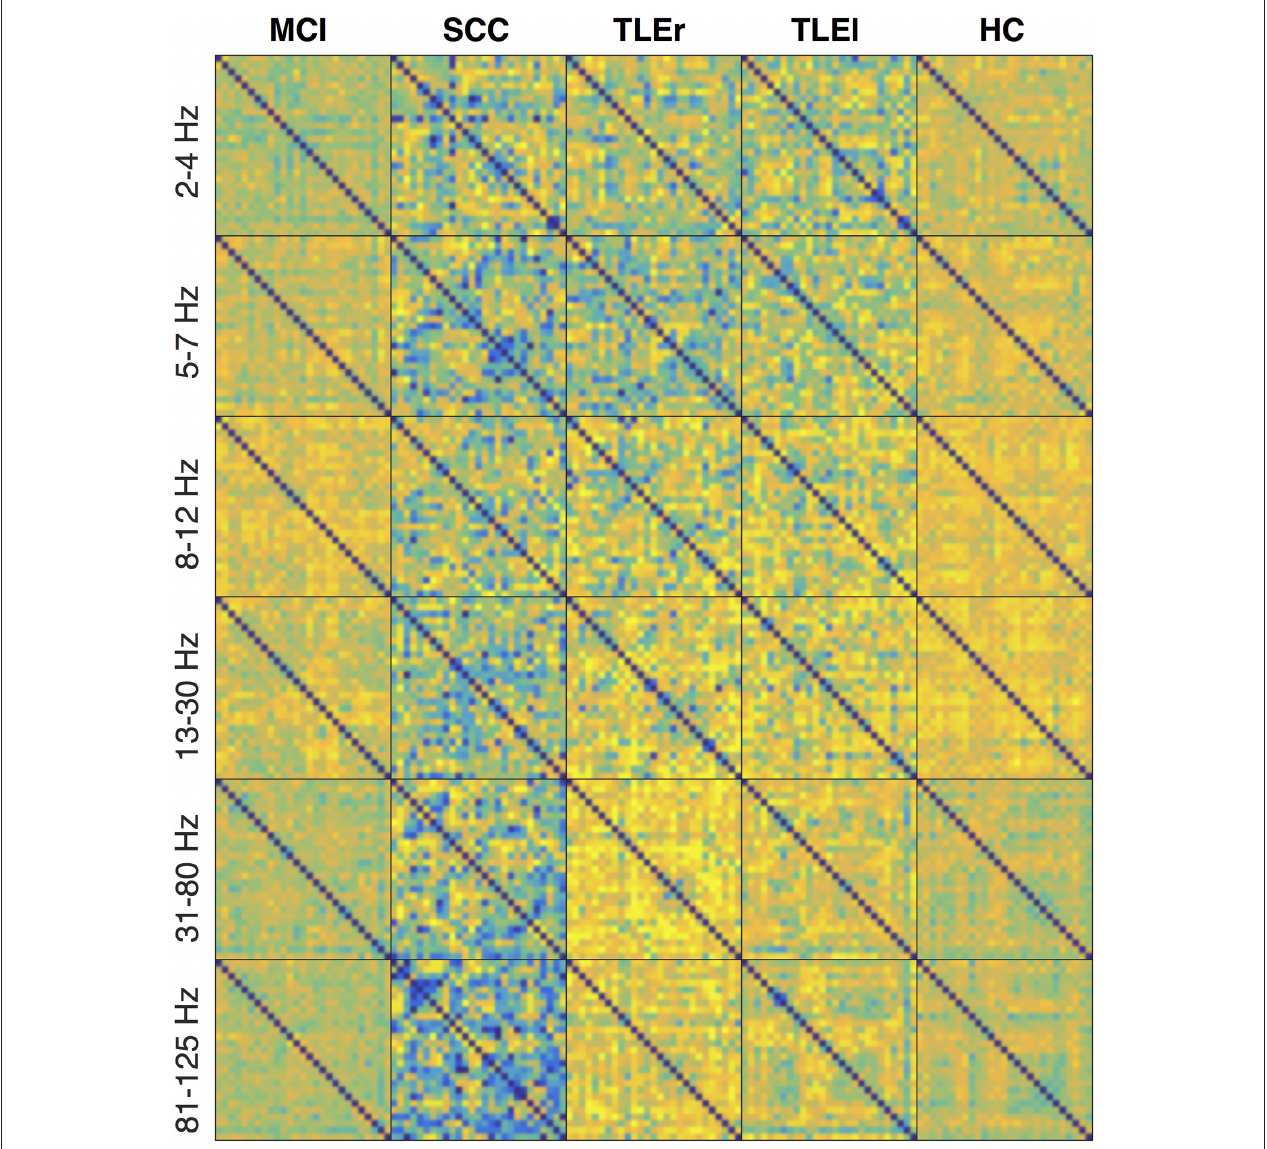
FIGURE 5 | Heatmaps of the reliability of all electrode × electrode interactions for real valued coherence, sorted by frequency in rows and groups in columns. Colors indicate values from − 1 (dark blue) to + 1 (bright yellow). Electrodes start from top left following the order: F3, F4, C3, C4, P3, P4, O1, O2, F7, F8, T7, T8, P7, P8, Fz, Cz, Pz, FC1, FC2, CP1, CP2, FC5, FC6, CP5, CP6, TP9, and TP10. MCI, mild cognitive impairment; SCC, subjective cognitive complaints; TLEr, right lateralized temporal lobe epilepsy; TLEl, left lateralized temporal lobe epilepsy; HC, healthy